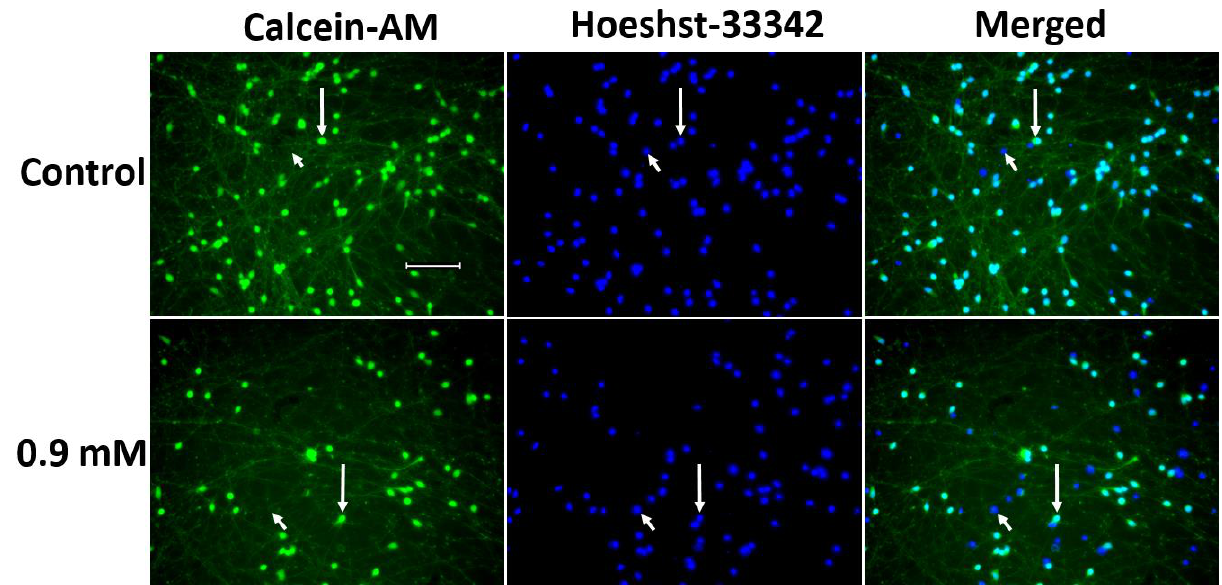
Figure 9. Decrease in the number of cell processes of LUHMES cells ( “ neurite mass ” ) and the num- ber of LUHMES cells stained with calcein-AM (calcein-acetoxymethyl ester) (green) after incubation for 48 h with 1-methyl-4-phenylpyridinium iodide at a concentration of 0.9 mM compared to control. Cell nuclei are stained with Hoeshst-33342 (blue). Long arrows, living LUHMES cells; short arrows, dead cells. Bar: 100 µm.